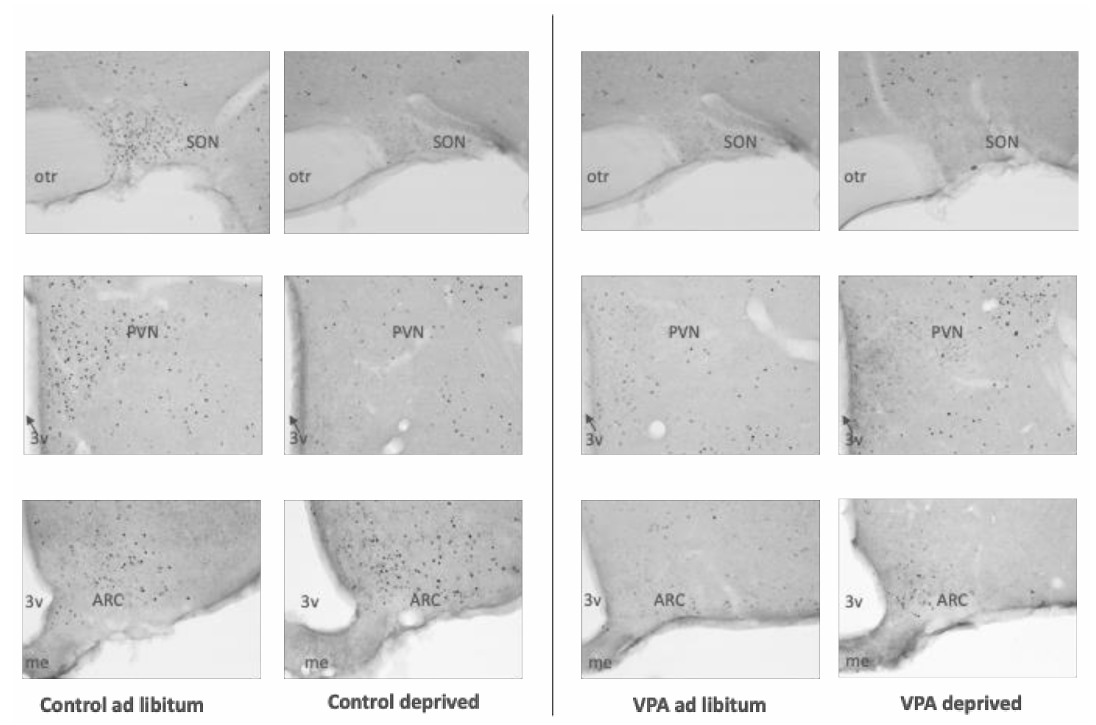
Figure 7. Photomicrographs depicting hypothalamic c-Fos IR. PVN—paraventricular nucleus of the hypothalamus, SON—supraoptic nucleus, ARC—arcuate nucleus, 3v—3rd ventricle, otr—optic tract.